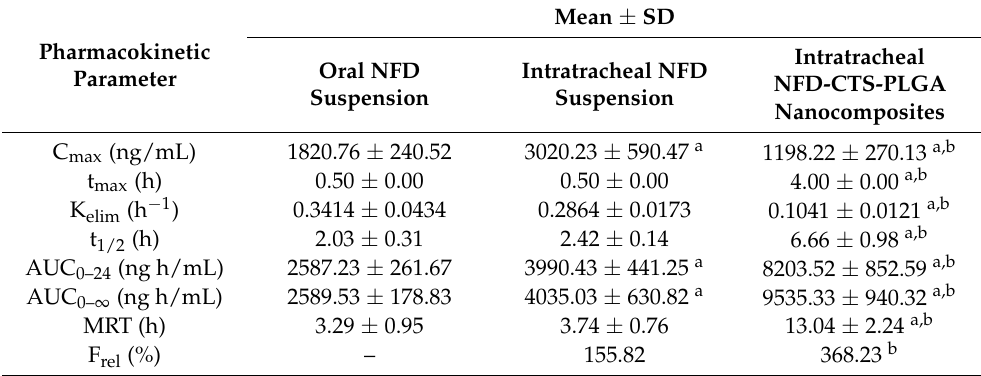
Table 6. Mean pharmacokinetic parameters in rat plasma following administration of oral NFD